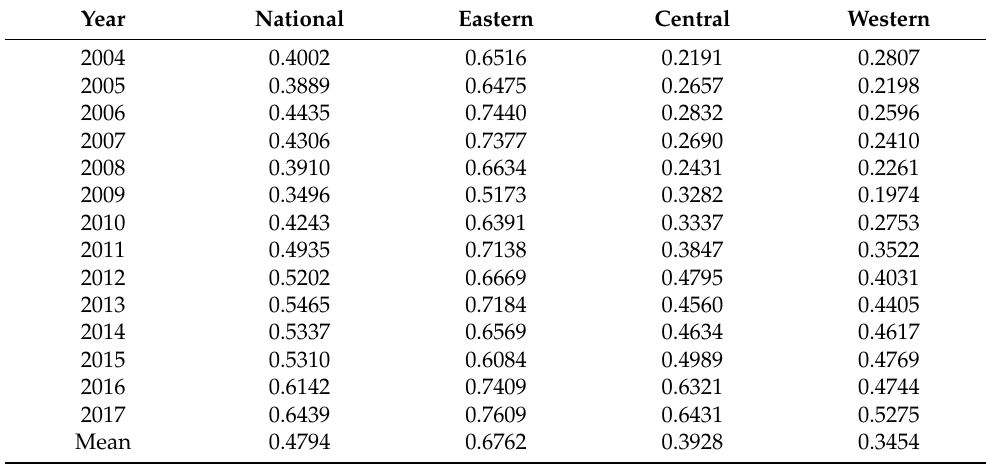
Table 2. GIE measurements in China,